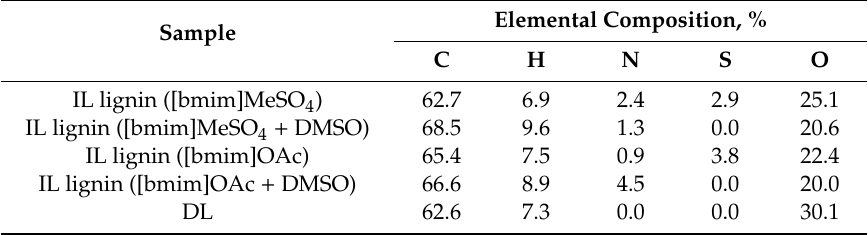
Table 3. Elemental composition of isolated IL lignins and dioxane lignin.